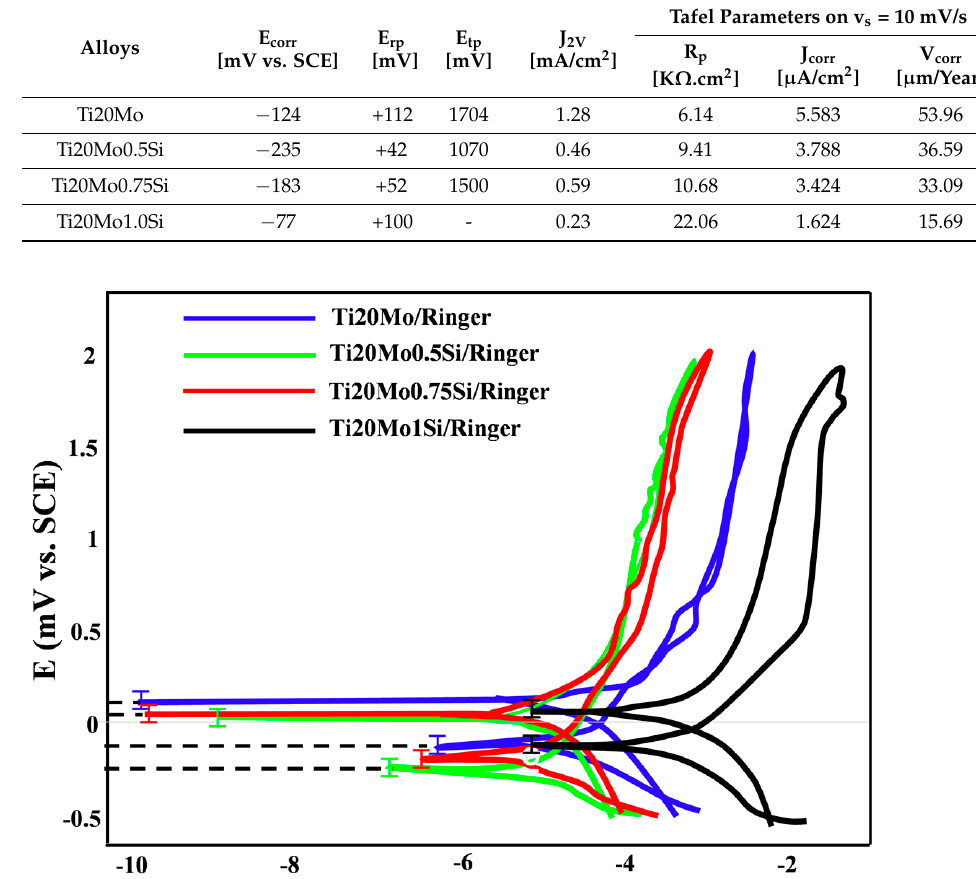
Figure 4. Corrosion parameters obtained from cyclic polarization curves in Ringer’s